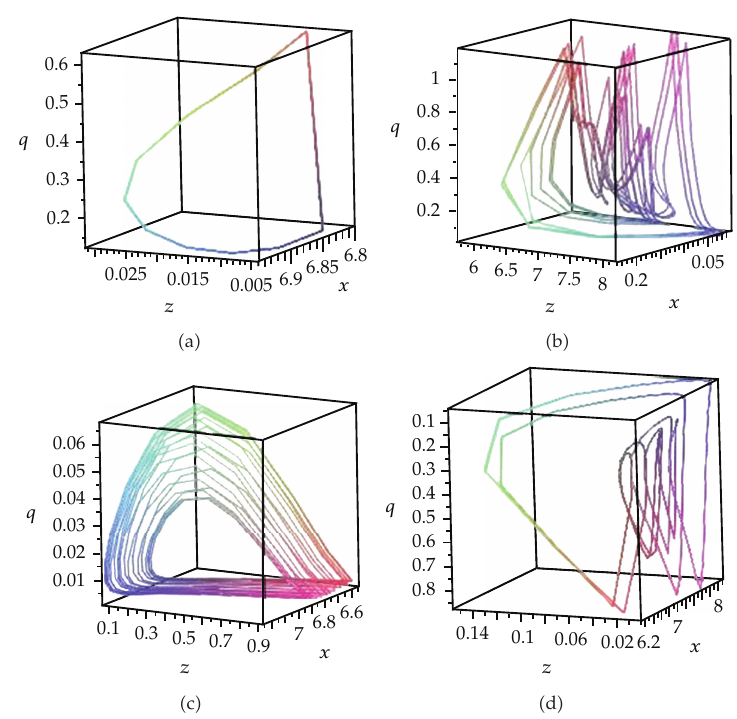
Figure 5: Periodic and chaotic behavior corresponding to Figure 2 as shown by phase diagrams: (cid:2) a (cid:3) T (cid:7) 10, (cid:2) b (cid:3) T (cid:7) 17, (cid:2) c (cid:3) T (cid:7) 15, and (cid:2) d (cid:3) T (cid:7) 27 .